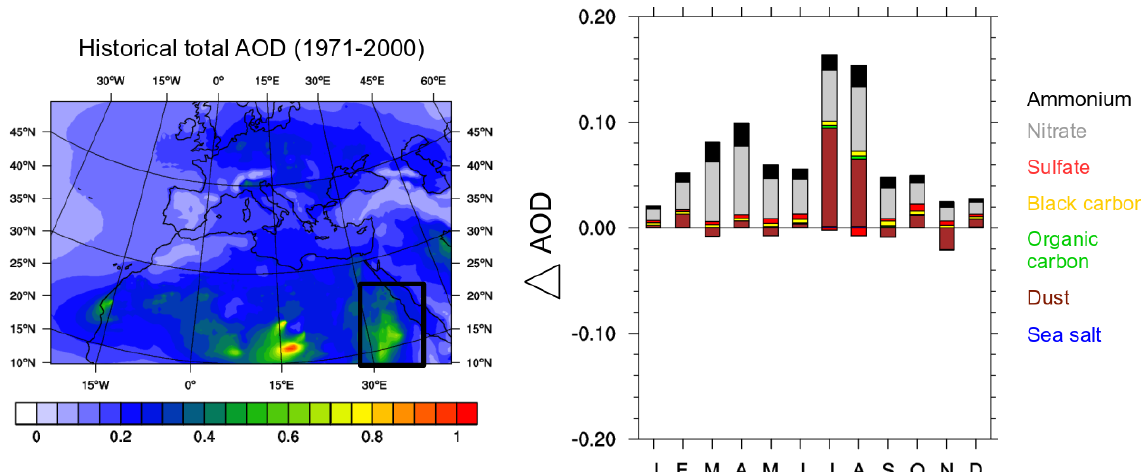
Figure 6. Historical total AOD and its evolution between the past period (1971–2000) and the future period (2021–2050) according to the SSP 5-8.5 over the East African region, which is framed in black. The hatched areas are statically non-significant with a threshold of 10%.